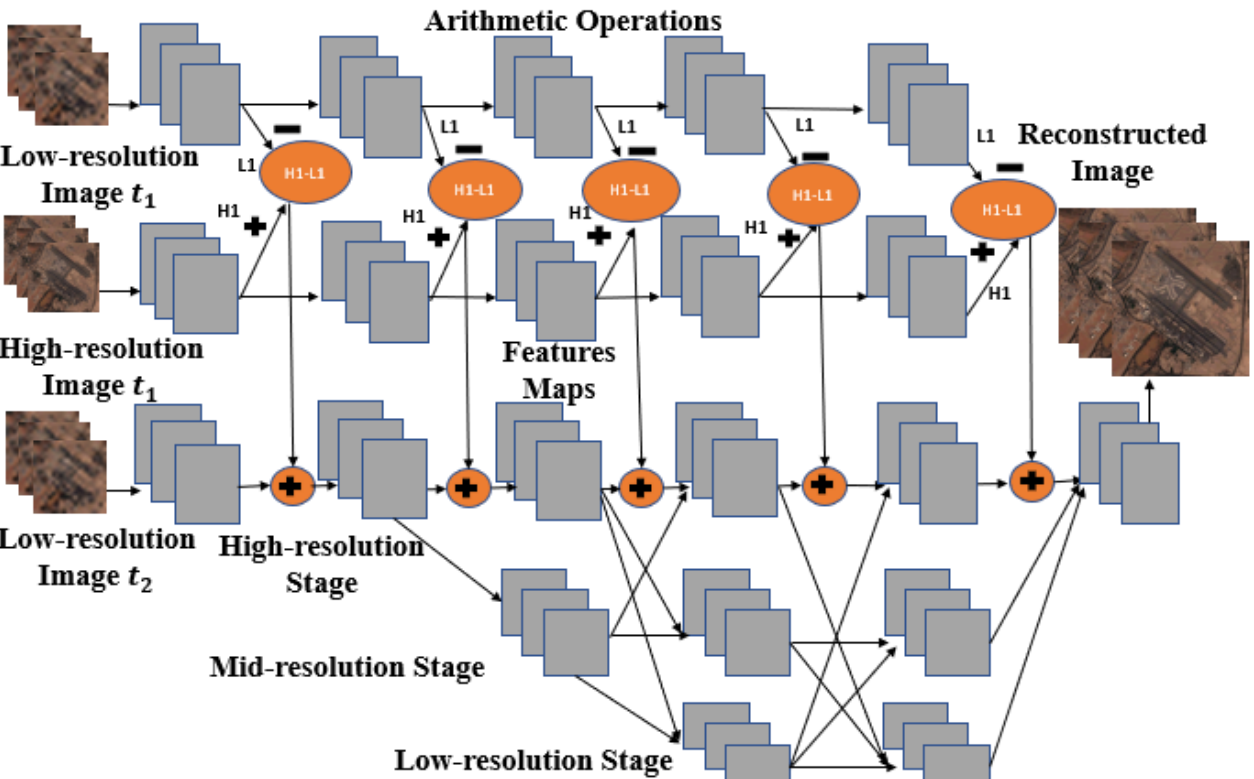
Figure 4. The high-resolution stage carries high-frequency information, which is crucial for sharper image generation, and the low-resolution stages account for large-scale contents in the images. The images in our experiments do not contain many large-scale changes between the two time points. As a consequence, arithmetic operations at lower-resolution stages may not provide much improvement. As the high-resolution stage carries high frequency information, we perform the same feature level arithmetic operations as those in the U-Net architecture in each convolutional layer at the high-resolution stage. We also conducted experiments by applying the arithmetic operations at all resolution stages. Nevertheless, only a marginal performance improvement was obtained with a significant increase in model complexity. Therefore, we chose this relatively simple structure. A similar histogram matching process is applied to all the images before training.